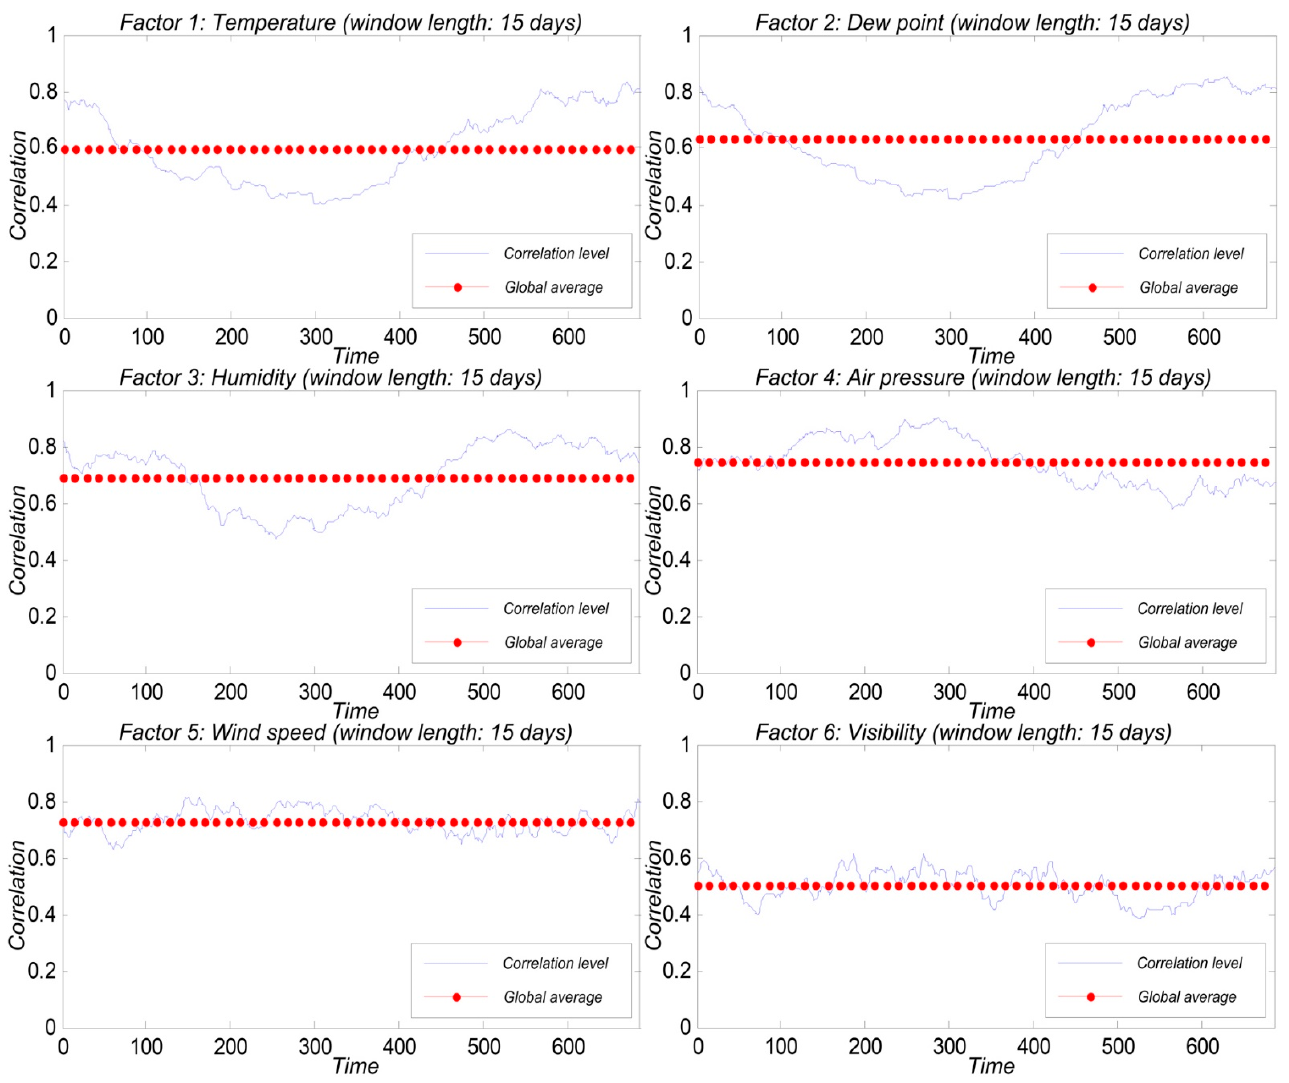
Figure 5. Grey correlation analysis of time window between meteorological parameters and PM2.5.